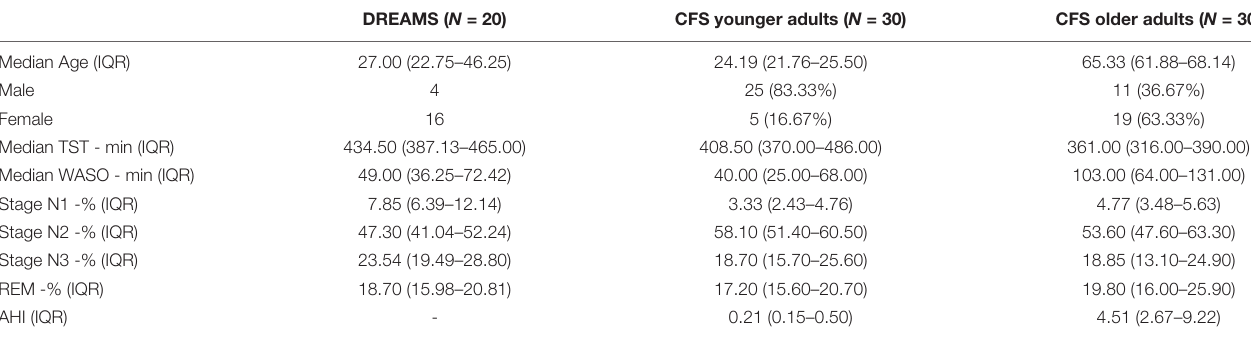
TABLE 1 | Demographics and sleep characteristics of the study